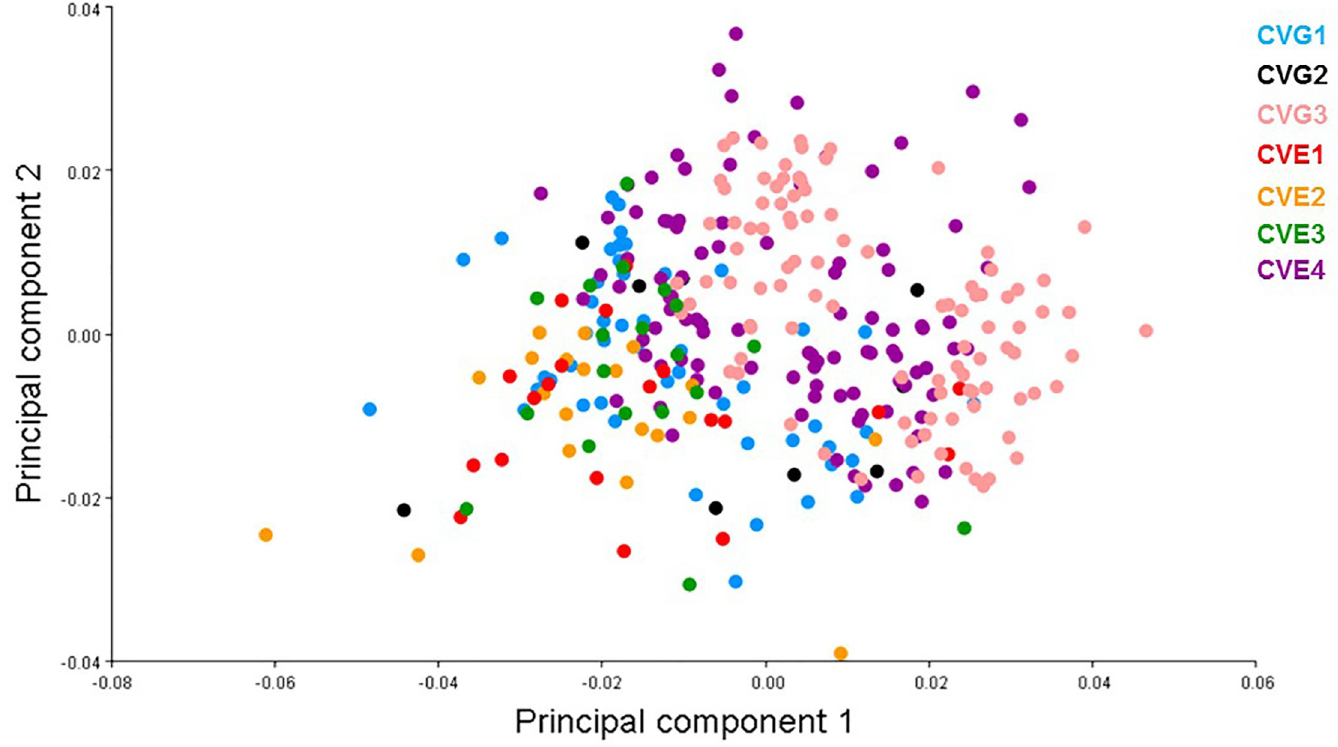
Fig 6. Projections of Procrustes-aligned landmark configurations on the first two principle components of the shape covariance matrix of C . vicina in each population, Germany (CVG1, CVG2, CVG3), England (CVE1, CVE2, CVE3, CVE4) see also Table 1.